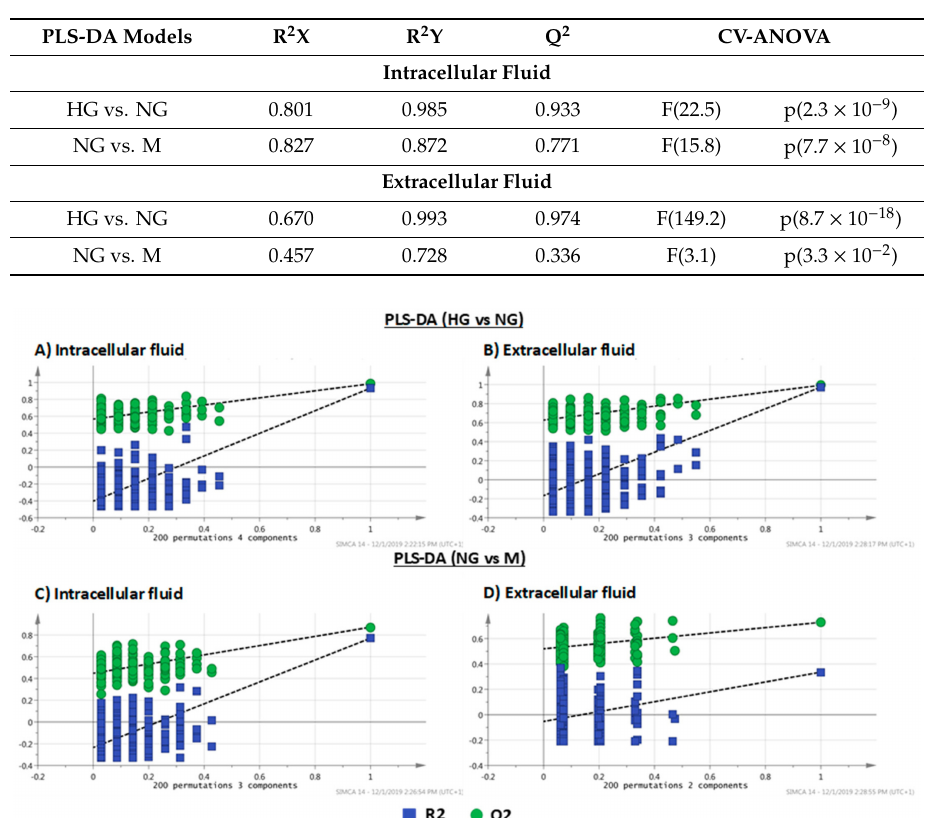
Table 1. R 2 X, R 2 Y, and Q 2 parameters and the F and p -values of the cross validated ANOVA (CV-ANOVA) for the PLS-DA models for the two analytical sequences.